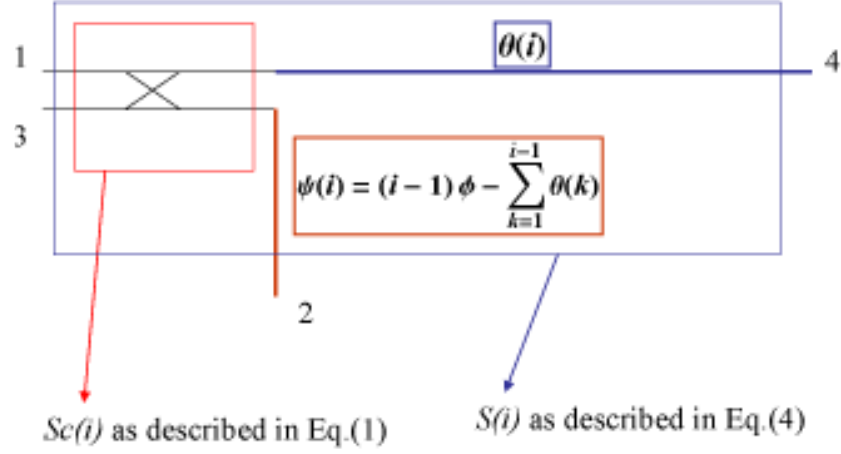
FIG. 2. (Color) The i th directional coupler representation.